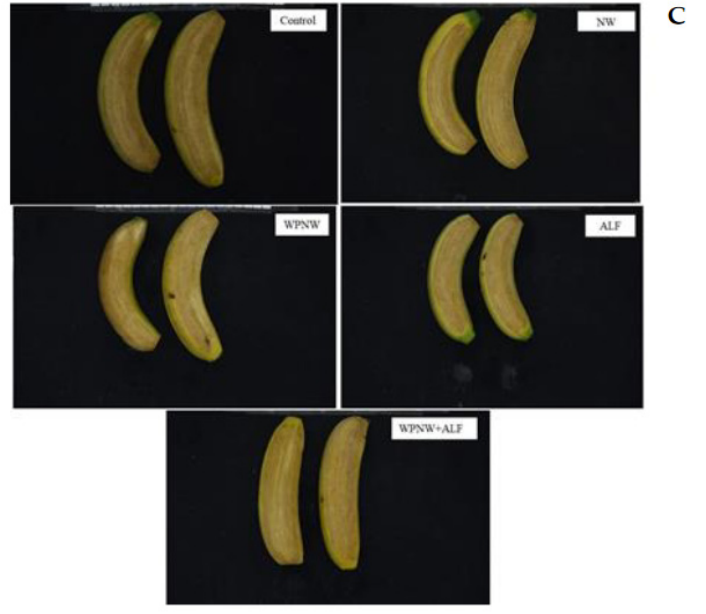
Figure 6. Chilling injury (CI) on banana with peel at mature green stage ( A ), and with or without peel at ripening stage ( B ) and ( C ) (winter trial).